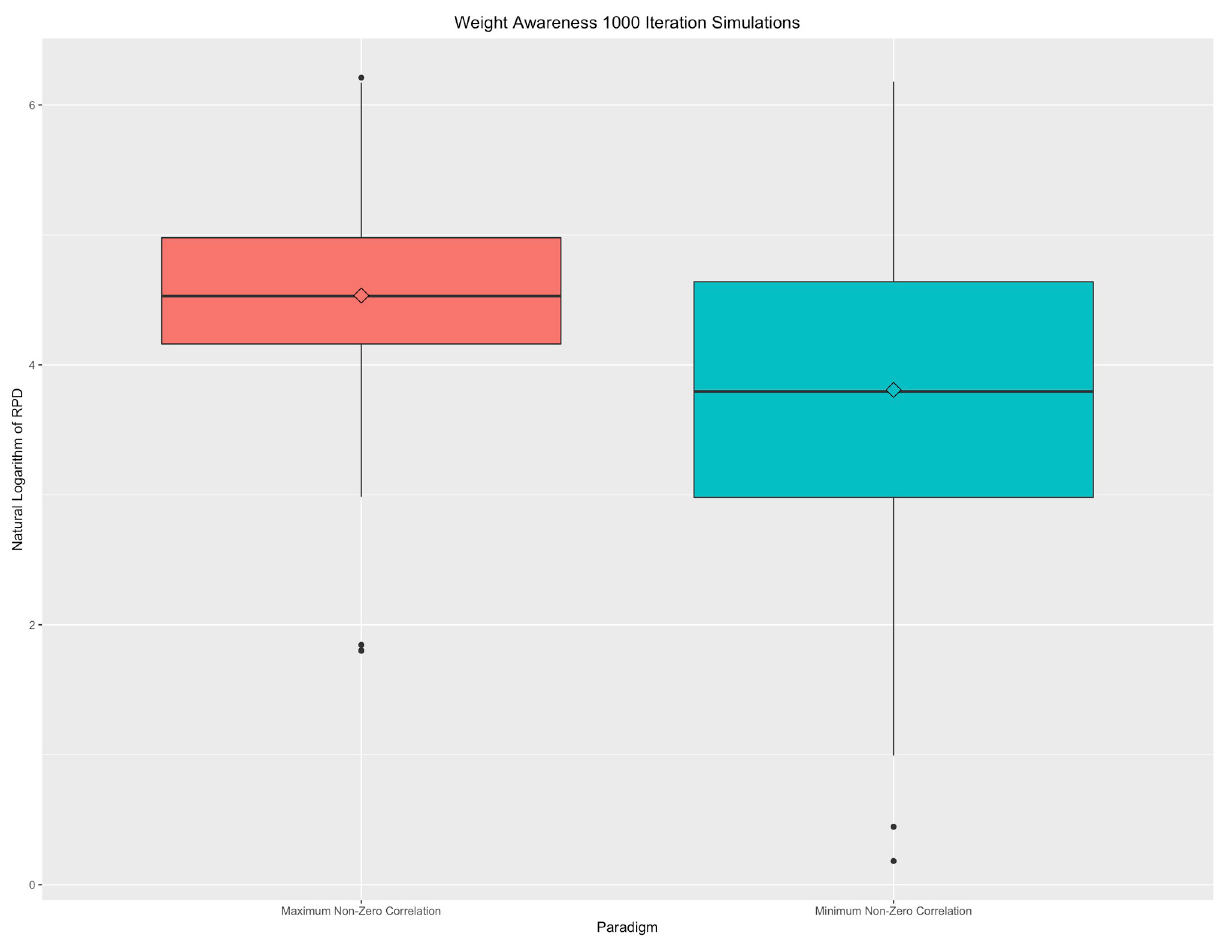
Fig 3. Weight awareness property. Boxplot of 1000 iterations under minimum and maxiumum non-zero correlation paradigms. A natural logarithm transformation has been applied to all resistance perturbation distance values for this figure. While minimum non-zero deletions result on a wider overall spread of distances, the maximum non-zero correlation deletions result, on average, in a larger RPD than a comparable minimum non-zero correlation deletion.